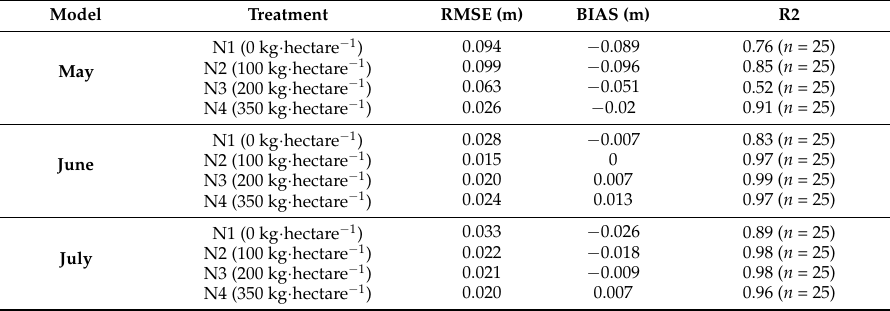
Table 9. Accuracy Assessment results of three different comparisons of rule measured and UAV measured heights. The results are grouped by the four nitrogen treatments applied within the diversity field experiment.